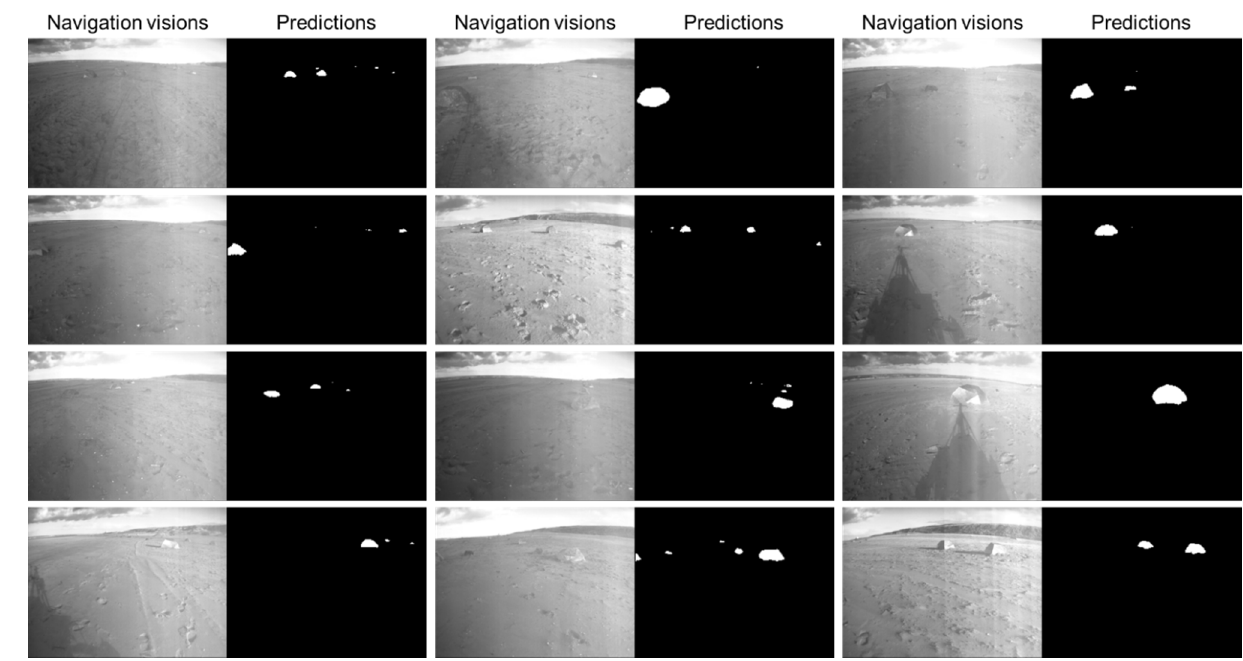
Figure A10. Some examples of the real-life rover vision and corresponding predictions.